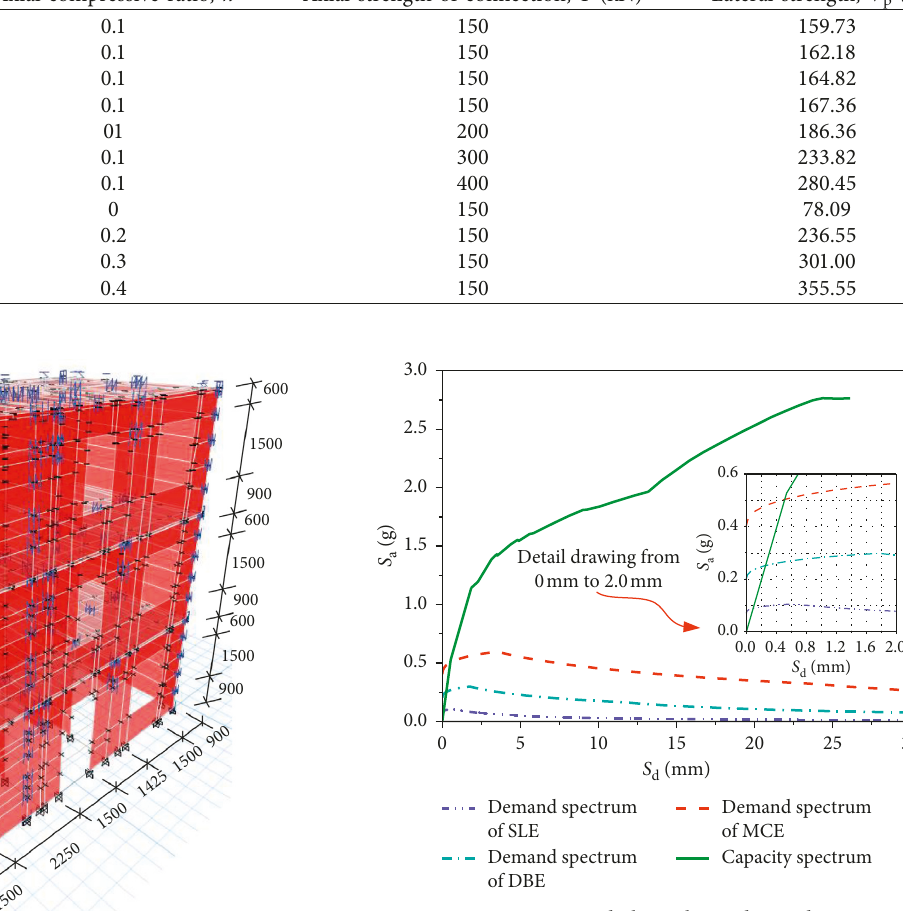
Figure 32: Capacity and elastoplastic demand spectrum.